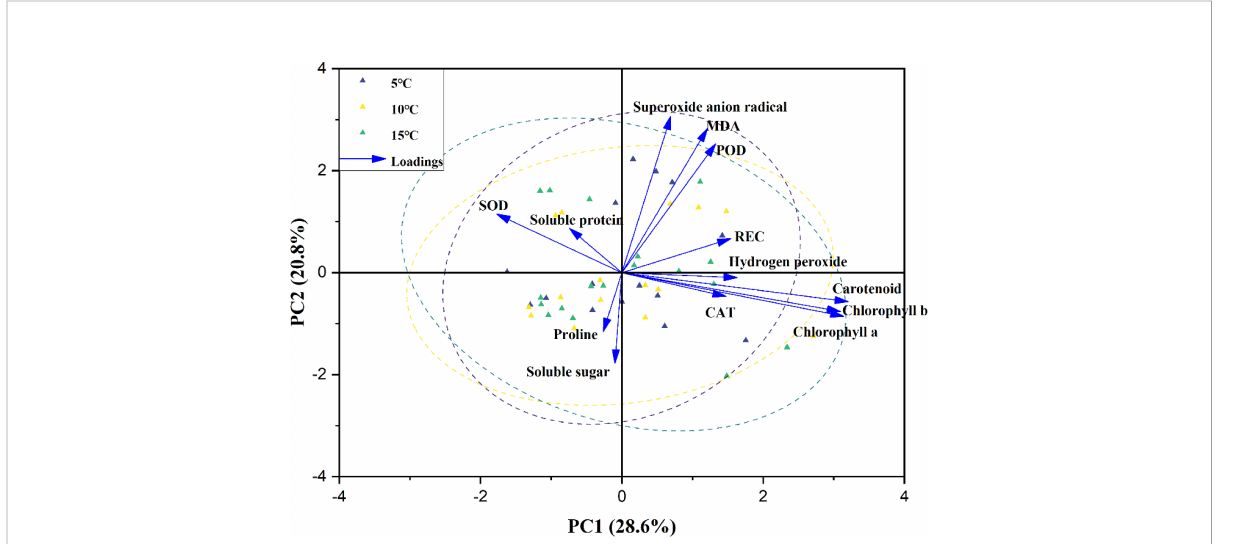
FIGURE 7 Biplot for the fi rst two principal components was analyzed using the principal component analysis (PCA) for 13 traits among 54 samples under 3 different upwelling temperature. Yellow, green and gray triangles are representing three different upwelling temperature. Arrows represented traits while its length is based on the contribution of each trait to separate the accessions. Relative electrical conductivity (REC), malondialdehyde (MDA), superoxide dismutase (SOD), peroxidase (POD) and catalase